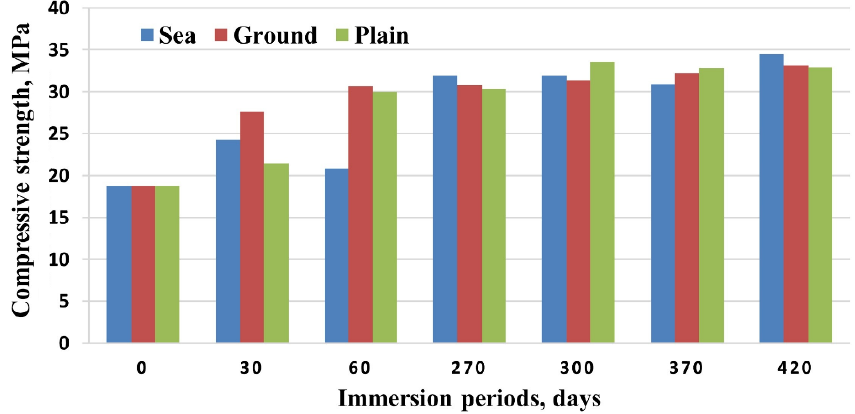
Figure 25. Impact of immersion periods on the compressive strength of the cement-polymer composites in plain, ground, and seawater. Reprinted with permission from ref. [67].